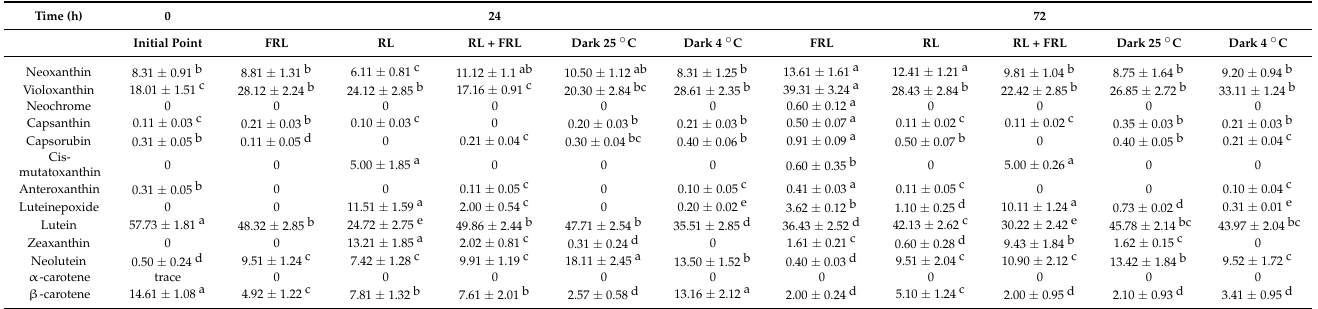
Table 2. The carotenoid compositions in percentages (%) of total content under the influence of RL, FRL and low temperature in C. annuum fruit after 24 and 72 h of the